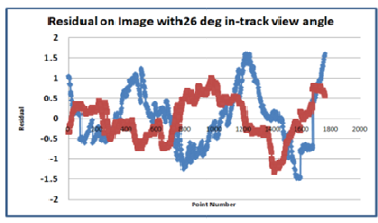
Fig. 8(b) Pl ot for image with 26 view angle Fig. 8 Plot of difference between rational polynomial coefficient